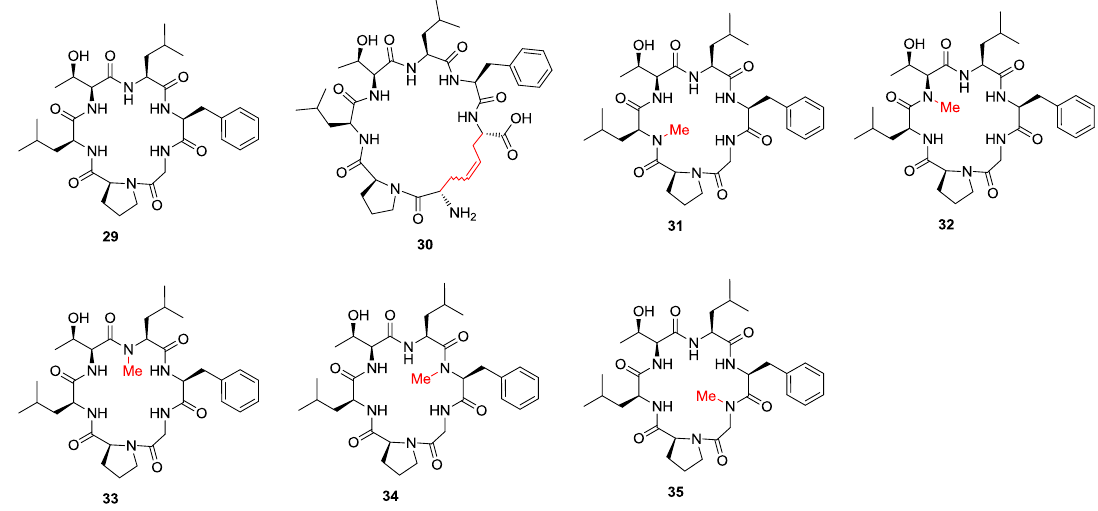
Figure 7. Structures of dianthin G ( 29 ), “dicarba” analogue 30 , and N -methyl analogues 31 – 35 .